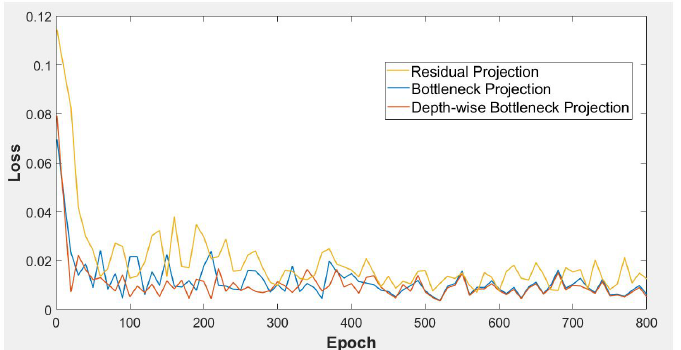
Figure 7. Average training loss per epoch for training our model with different projection approaches on the DIV2K dataset.